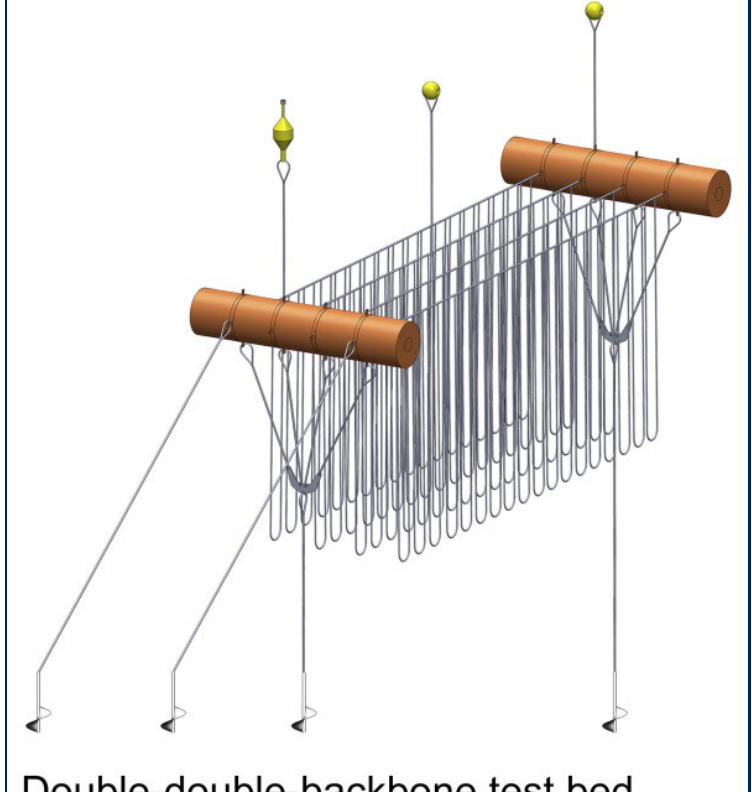
Figure 26. Submersible mussel cultivation structure [57].